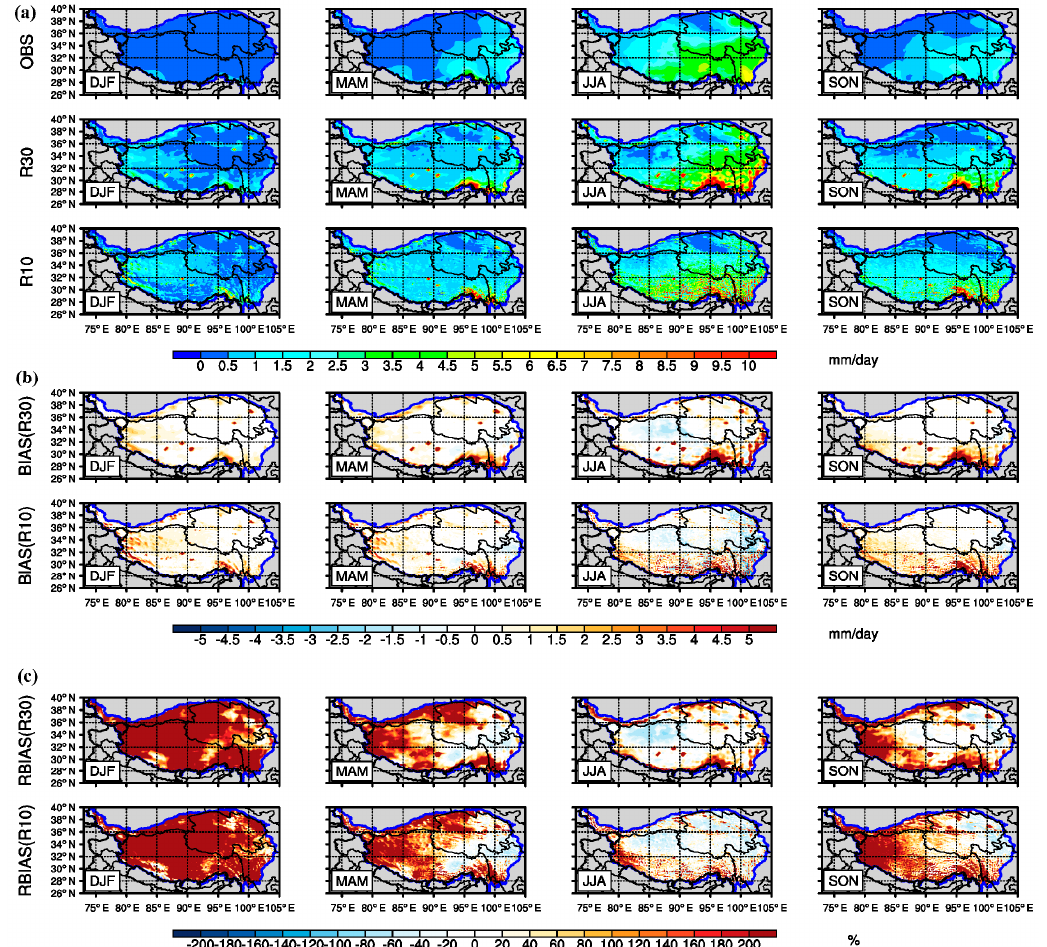
Figure 3. Simulated seasonal mean precipitation ( a , top panel ) and biases ( b , middle panel ) for 1980 − 2010 in mm/day and relative biases ( c , bottom panel ) in percentage terms.